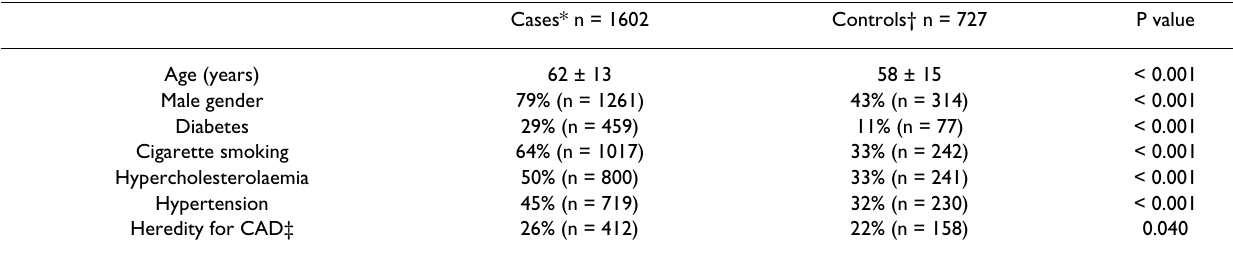
Table 1: Baseline characteristics of the study